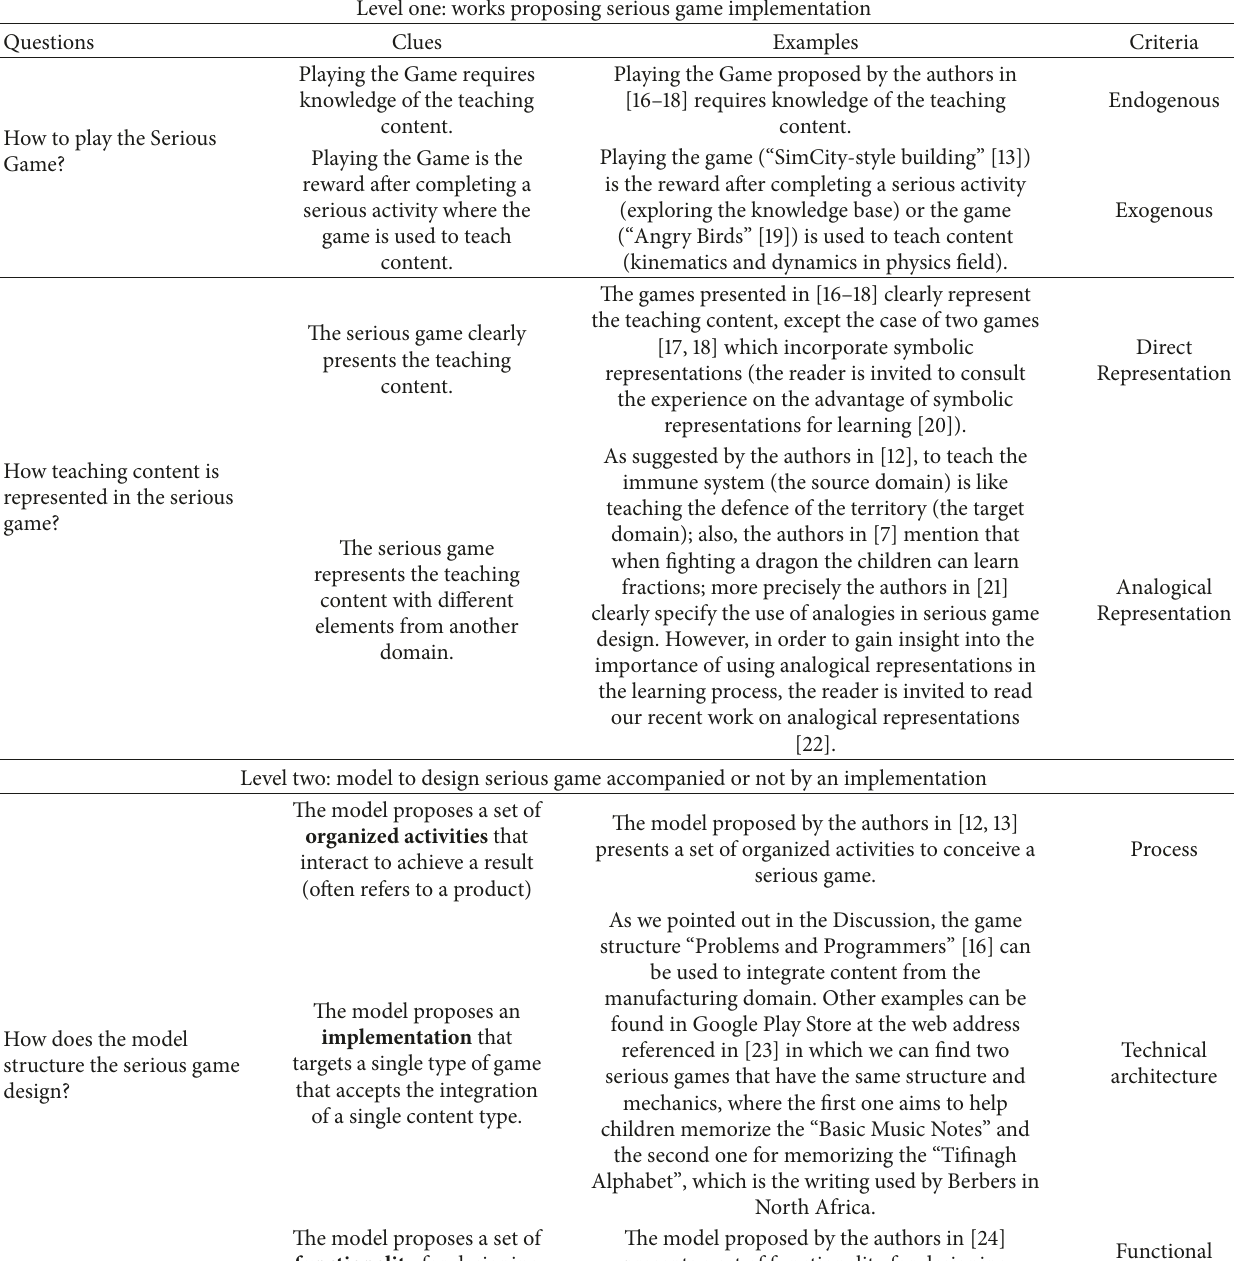
Table 1: The grid of questions used during the